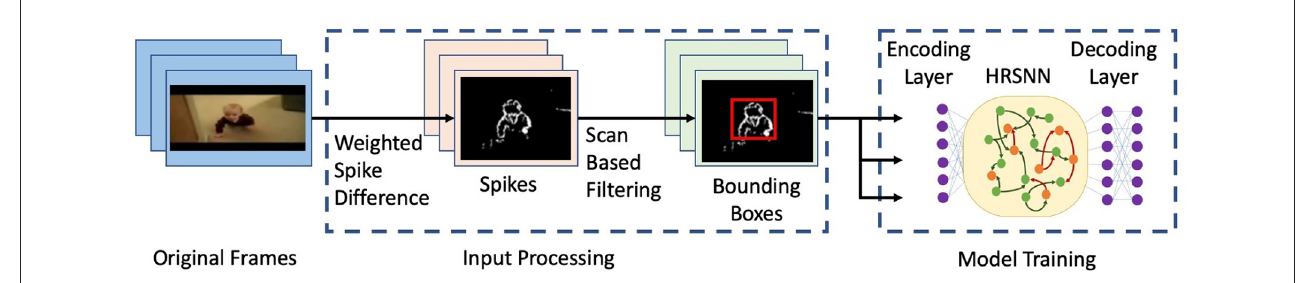
FIGURE2 Figure showing a flowchart for the input processing and model training. The figure shows selected frames from a video of the UCF101 dataset (Soomro et al.,